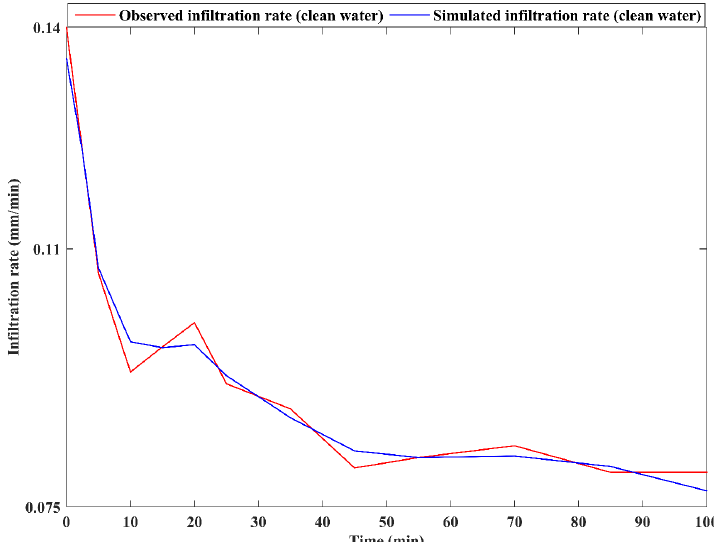
Figure 4. Comparison of the infiltration rate observed for the clean water (0 g/L) with that of the reconstructed using